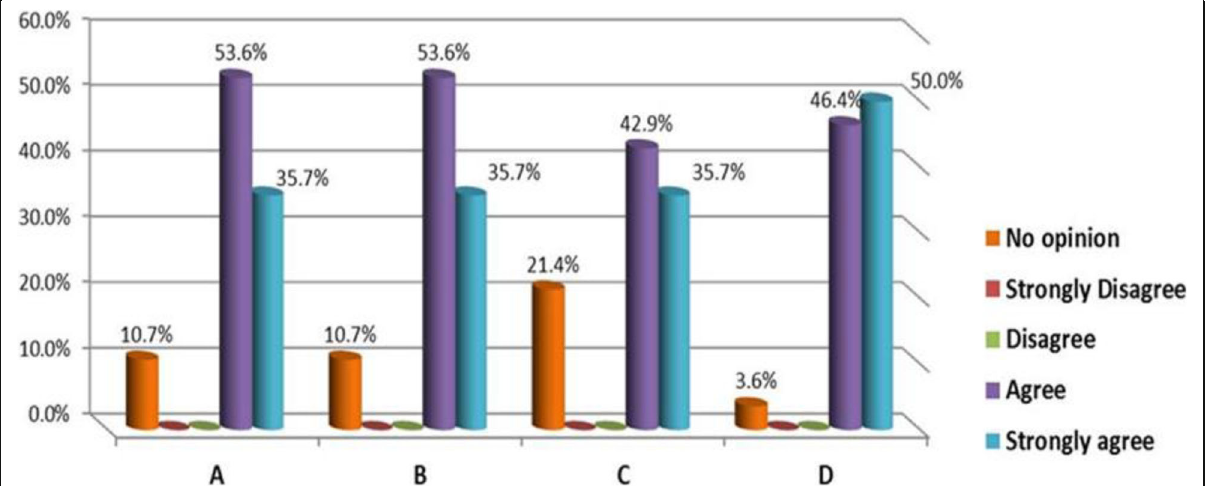
Fig. 1 Pre-education basic knowledge of the respondents ’ physicians and pharmacists about antimicrobial use. a . Inappropriate antibiotics use can lead to resistance, b . Inappropriate antibiotics use can lead to ineffective treatment, c . Inappropriate antibiotics use can lead to increase adverse effects, d . Inappropriate antibiotics use gives additional burden of medical cost to the patient